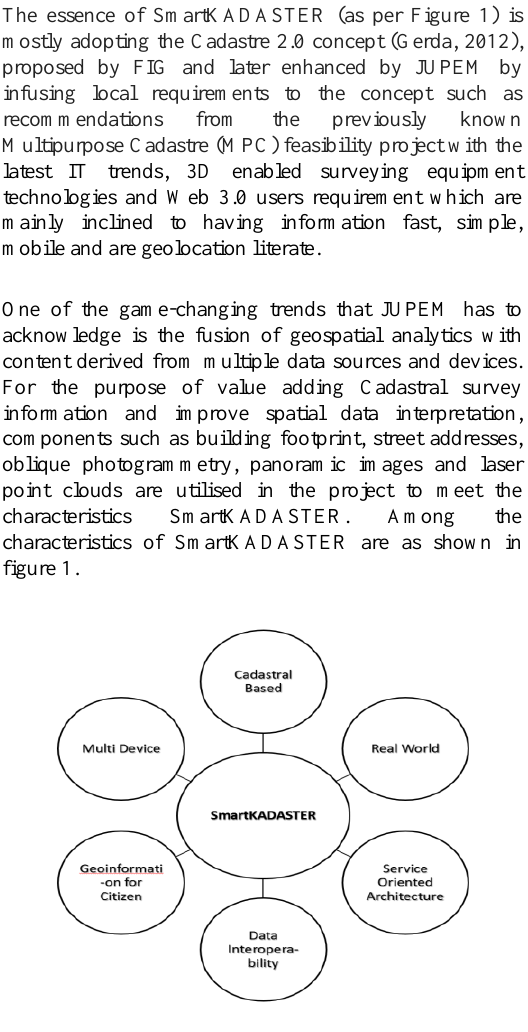
5. SMARTKADASTER INTERACTIVE